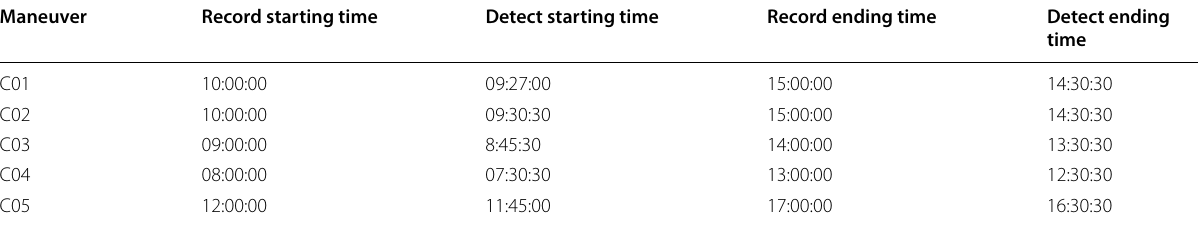
Table 4 Comparison between the detected time and the recorded time by the broadcast ephemeris Maneuver Record starting